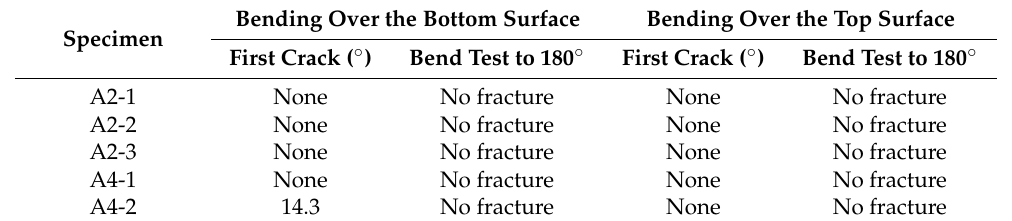
Table 4. Bend test results.